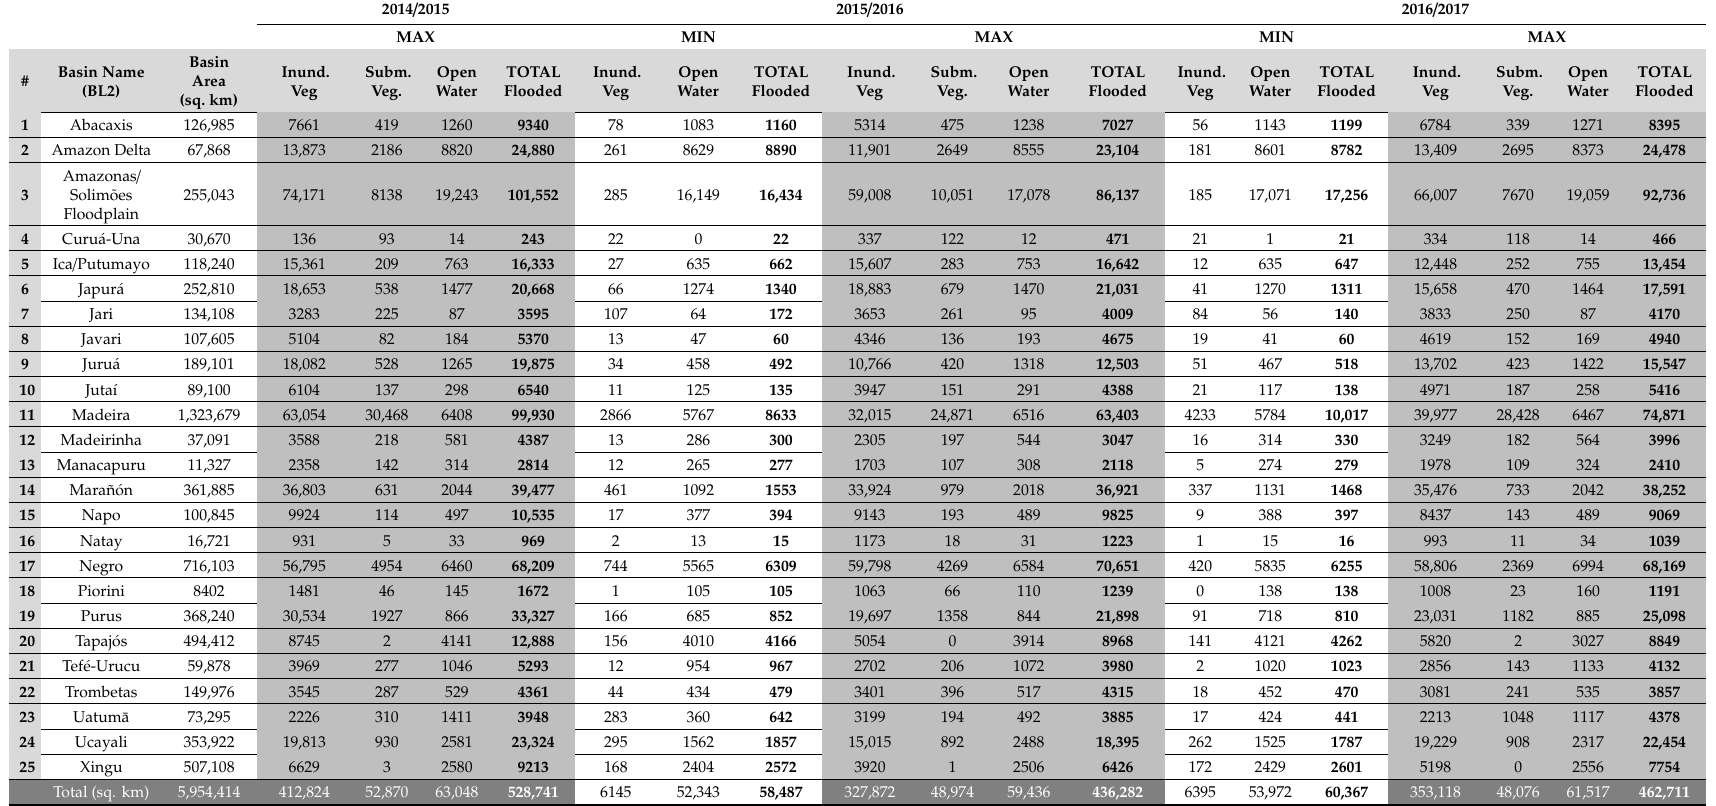
Table 2. Maximum and minimum inundation area estimates Nov. 2014 – Oct 2017 for Amazon basin tributary rivers, Basin Level 2 as per Venticinque et al.